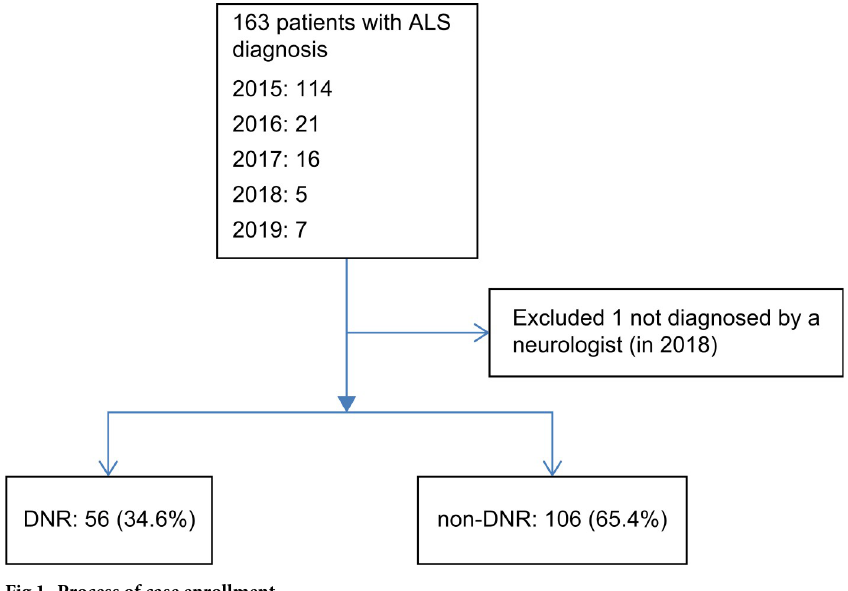
Fig 1. Process of case